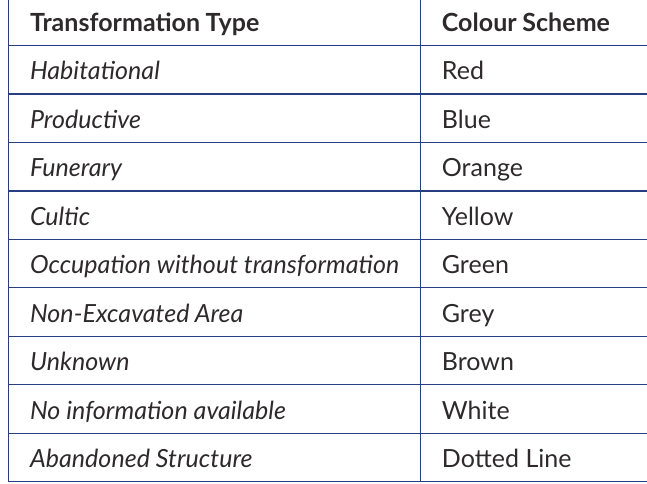
Table 3: Breakdown of colour scheme used in this methodology (J. Dodd).